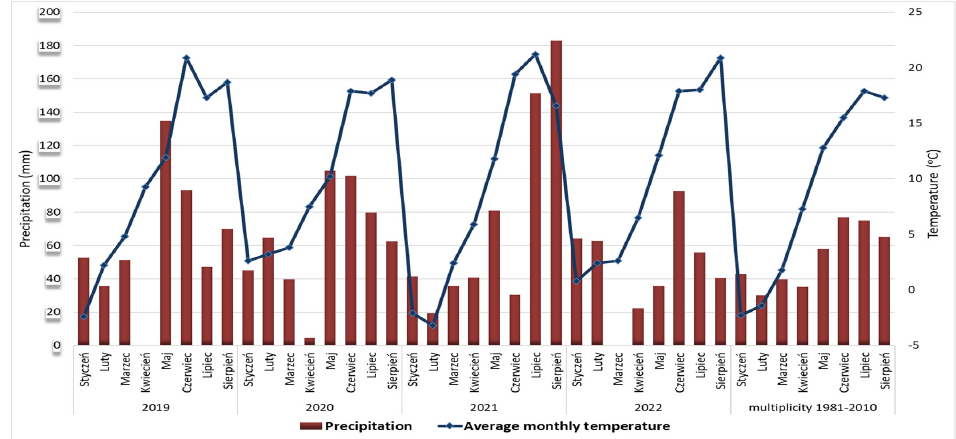
Figure 2. Precipitation and monthly average temperatures in Olsztyn (north ‐ eastern Poland) from January to August in 2019–2022 and the multiannual period 1981–2010 (data obtained and processed from the station of the Institute of Meteorology and Water Management IMGW ‐ PIB).